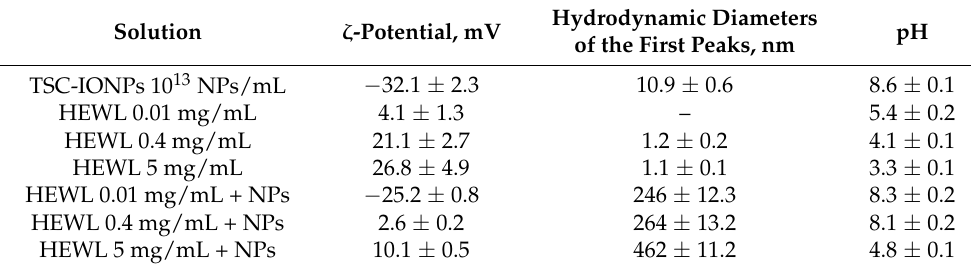
Figure 6. Distribution (weighted by intensity) of hydrodynamic diameters of molecules and aggregates for different concentrations of NPs (from 10 11 to 5 × 10 13 mL − 1 ) and different concentrations of HEWL: 0.01 ( a ), 0.4 ( b ), 5 ( c ) mg/mL. ( d ) Dependence of the average size of hydrodynamic diameter on the concentration of NPs (* p < 0.05). Polydispersity index for all measurements in the Supplemen- tary Materials (Figure S7). Results are presented as mean and SD for five independent experiments. Table 2. ζ -potential (mV), hydrodynamic diameters of the first peaks (MADLS data), and pH (electrode InLab Expert Pro-ISM measured in SevenExcellence pH/Cond meter S470) for HEWL and TSC-IONPs (10 13 NPs/mL) and the association. Results are presented as mean and SD for three independent